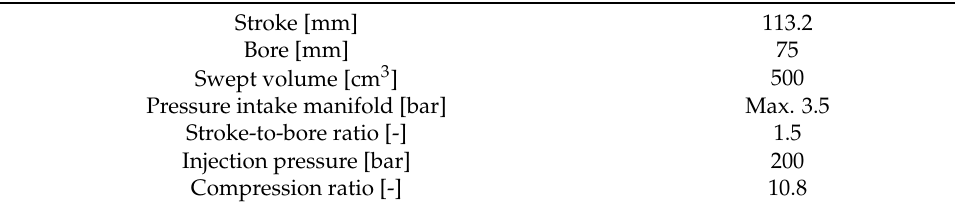
Table 2. Single cylinder engine